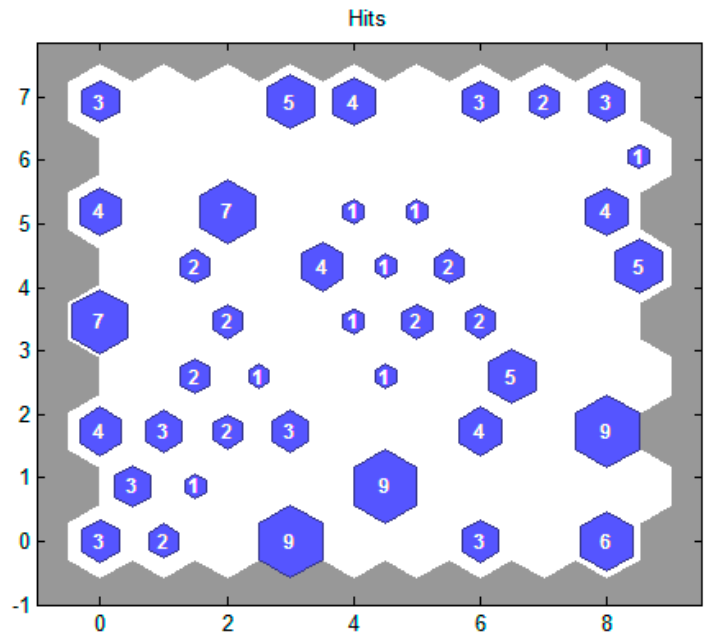
Figure 9. The structure of the neurons used and the quantity of assigned data.